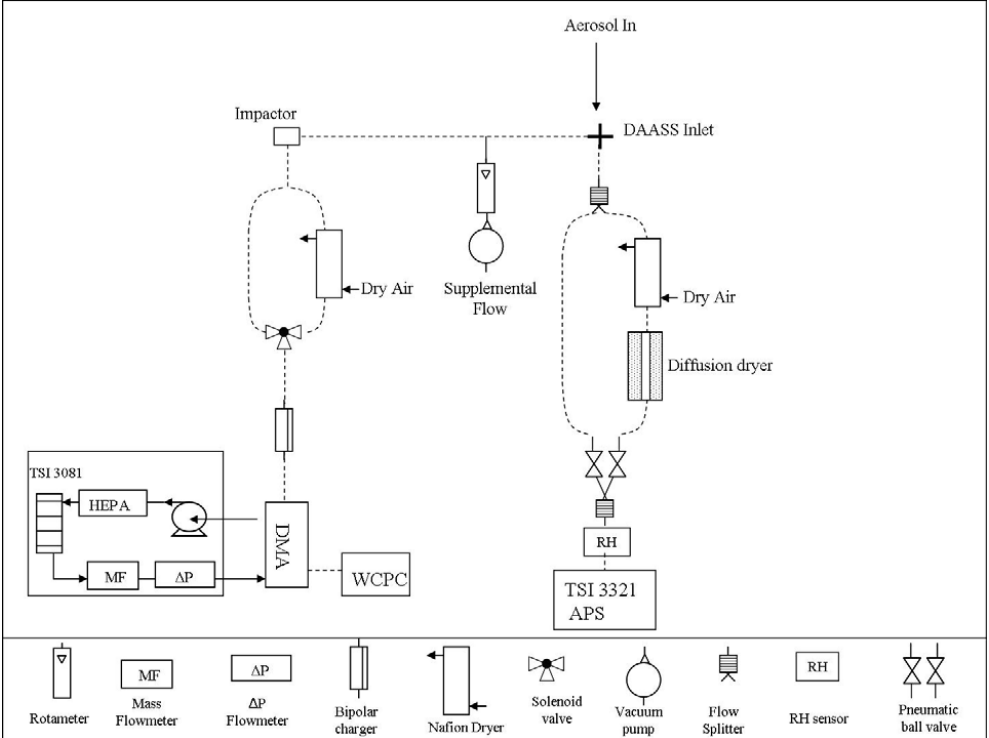
Figure 1. University of Iowa RH-controlled inlets and sizing instrumentation. Fig. 1. University of Iowa RH-controlled inlets and sizing